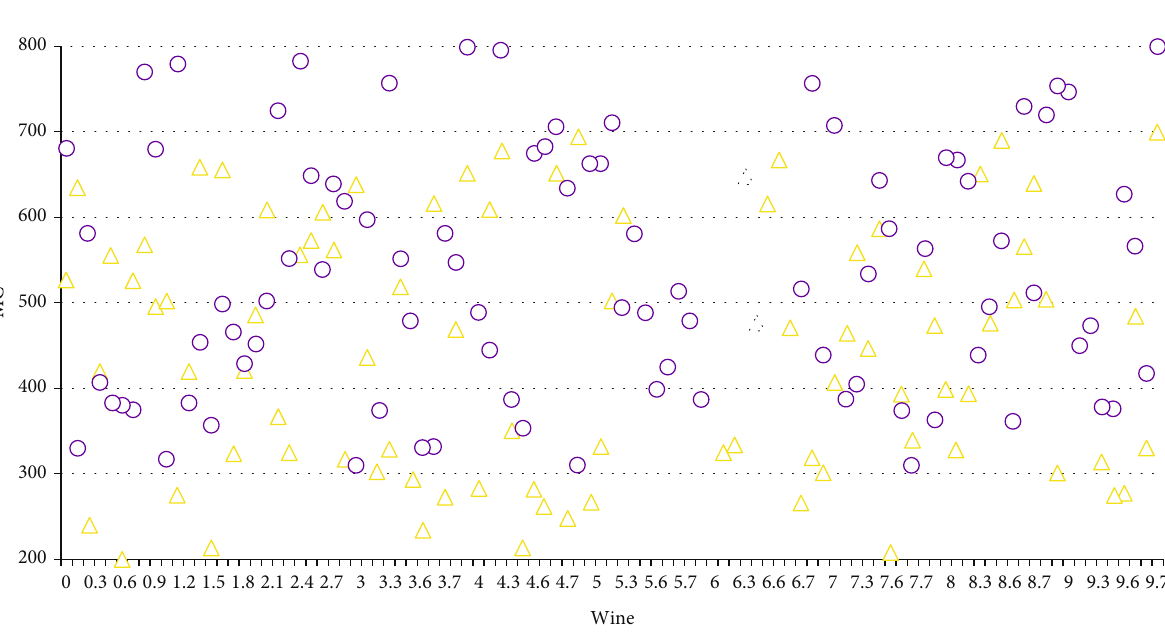
Figure 5: Schematic diagram before processing.